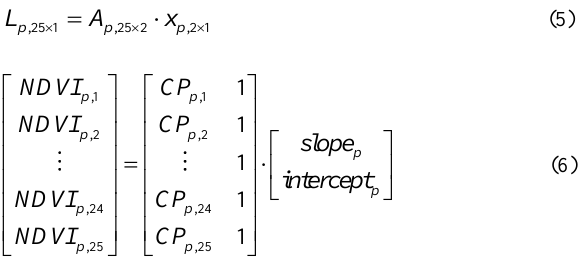
The linear regression coefficient layers and the multi-temporal NDVI layers were classified into 9 classes (Figure 3) using SVM supervised classification. Table 3 presents the description of the classes. Figure 4 presents the results of SVM multi-temporal classification of the 25 layers of NDVI corresponding to the dates of Sentinel2 images (Figure 4a) and the results of SVM classification of the extended regression analysis between NDVI and rainfall and PET accumulated for 2 months (Figure